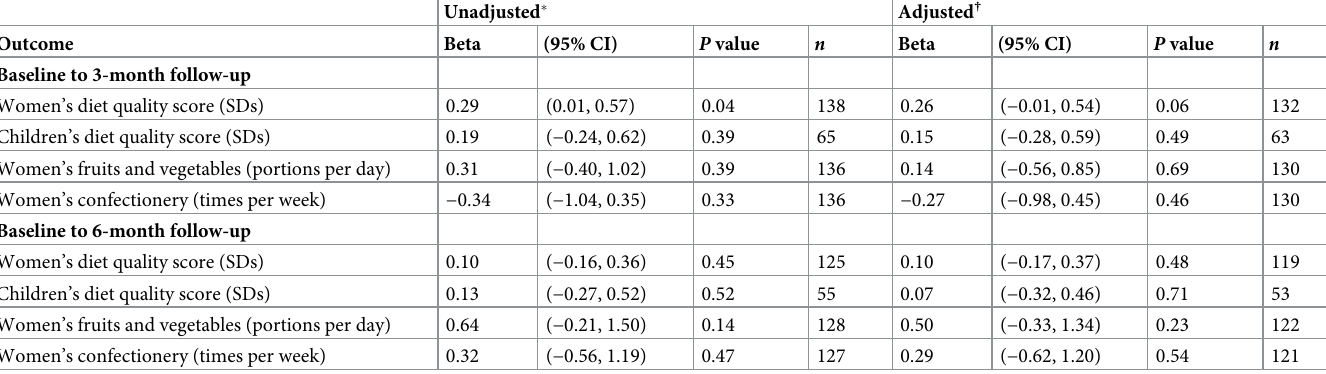
Table 2. Effect of intervention on women’s and children’s dietary change from baseline to 3- and 6-month follow-up postintervention.